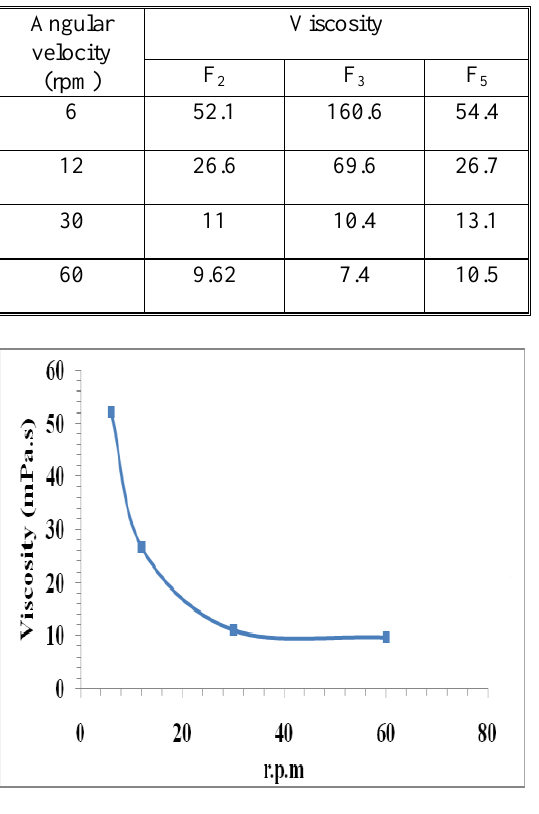
Table (3): Viscosity Values for the Selected Formulations (F